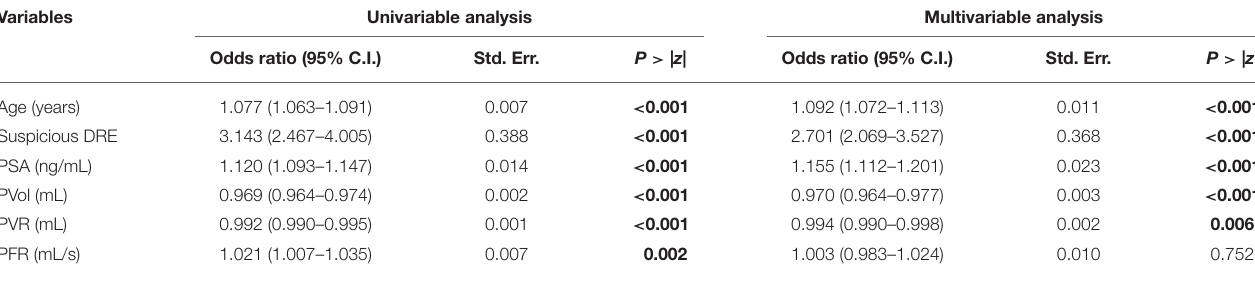
TABLE 3 | Univariable and multivariable binary logistic regression analysis testing the value of clinical variables in predicting clinically significant Prostate Cancer (ISUP > 1). Variables Univariable analysis Multivariable analysis Odds ratio (95% C.I.)